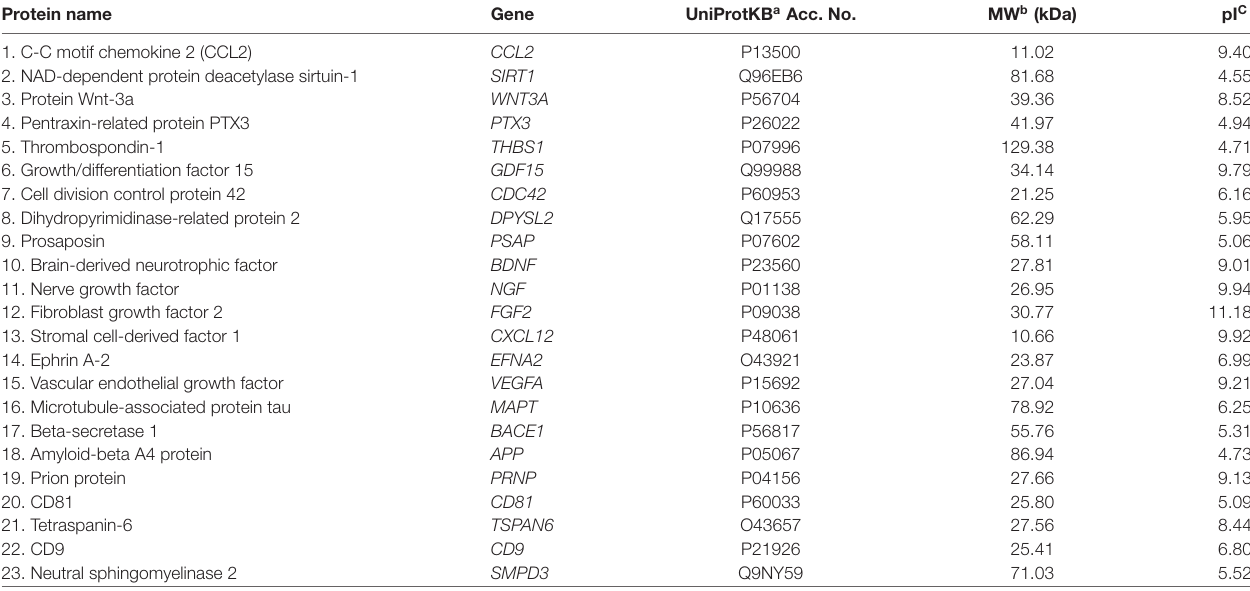
TABLE 1 | Polypeptides identified in exosomes derivate from Mesenchymal Stem Cells (MSC). Protein